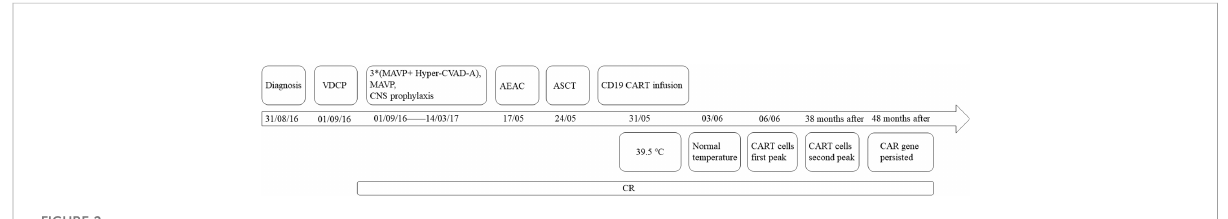
FIGURE 2 Timeline of treatment and ef fi cacy. *multiply: six courses of alternative therapy with Hyper-CVAD-A (cyclophosphamide, vindesine, doxorubicin, and dexamethasone), MAVP (methotrexate, cytarabine, vindesine, and dexamethasone).